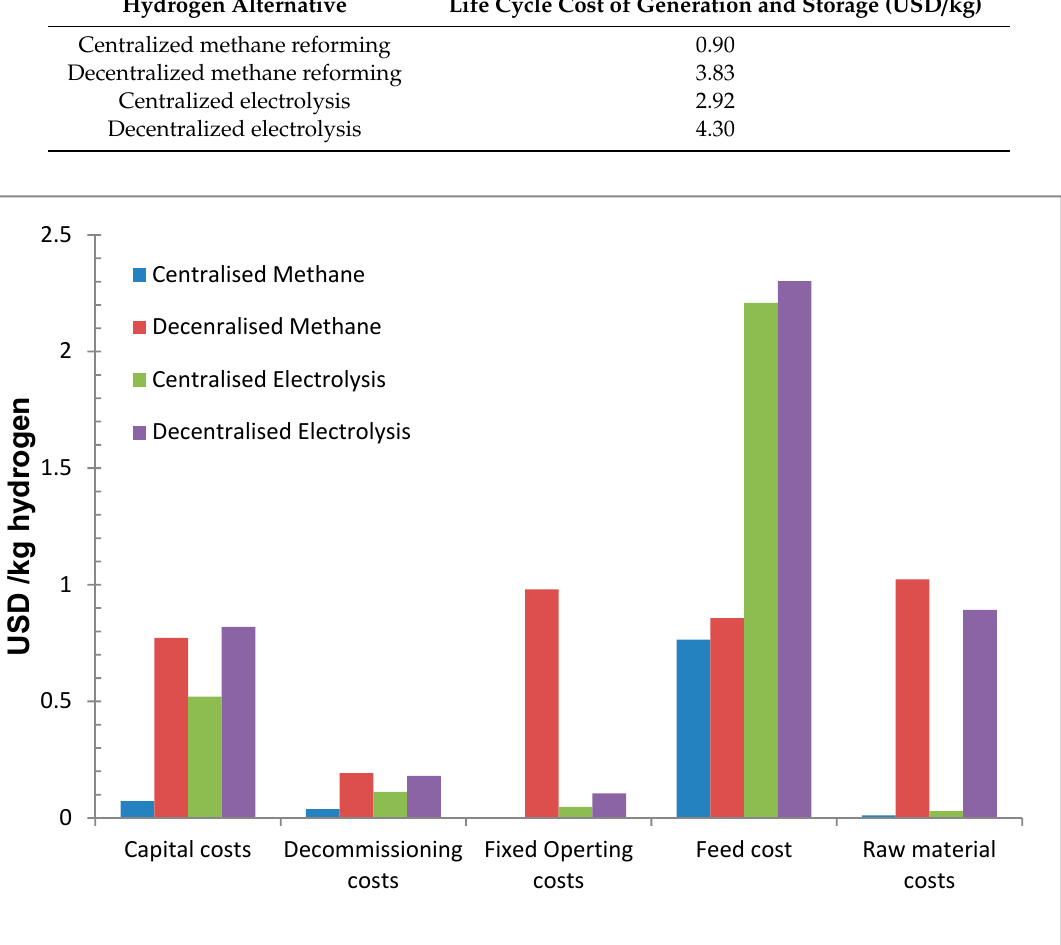
Table 4. Life cycle costs of hydrogen production and storage, minimum rate of return of investment. Hydrogen Alternative Life Cycle Cost of Generation and Storage (USD / kg)